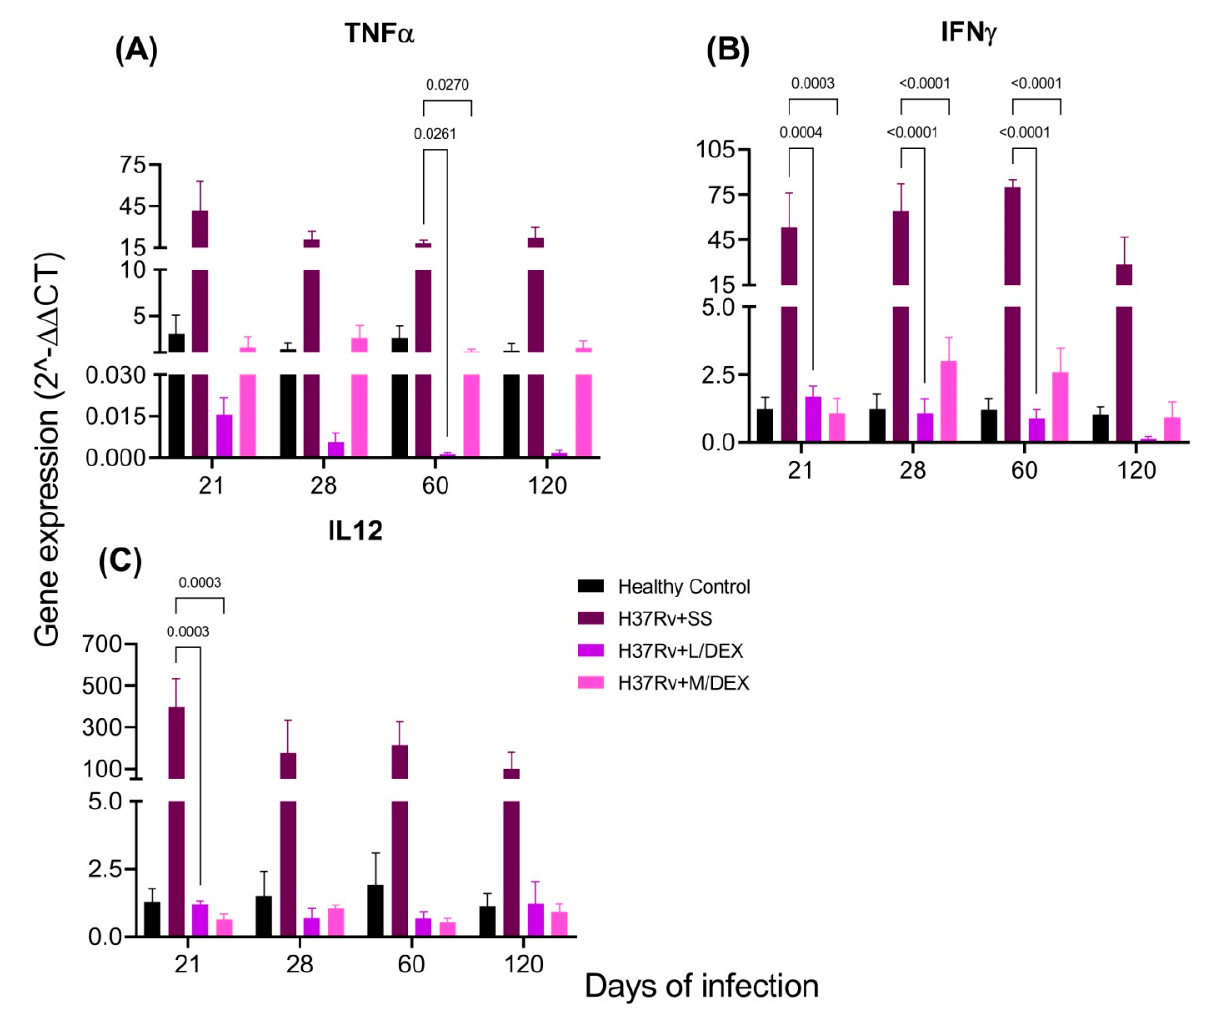
Figure 7. Effect of L/DEX (0.05 mg/kg BW) and M/DEX (0.25 mg/kg BW) on pro-inflammatory cytokines of the hypotha- lamus of mice infected with Mtb H37Rv. ( A ) TNF α . F (3, 29) = 14.50, p < 0.0001. REML. Dunnett’s multiple comparisons